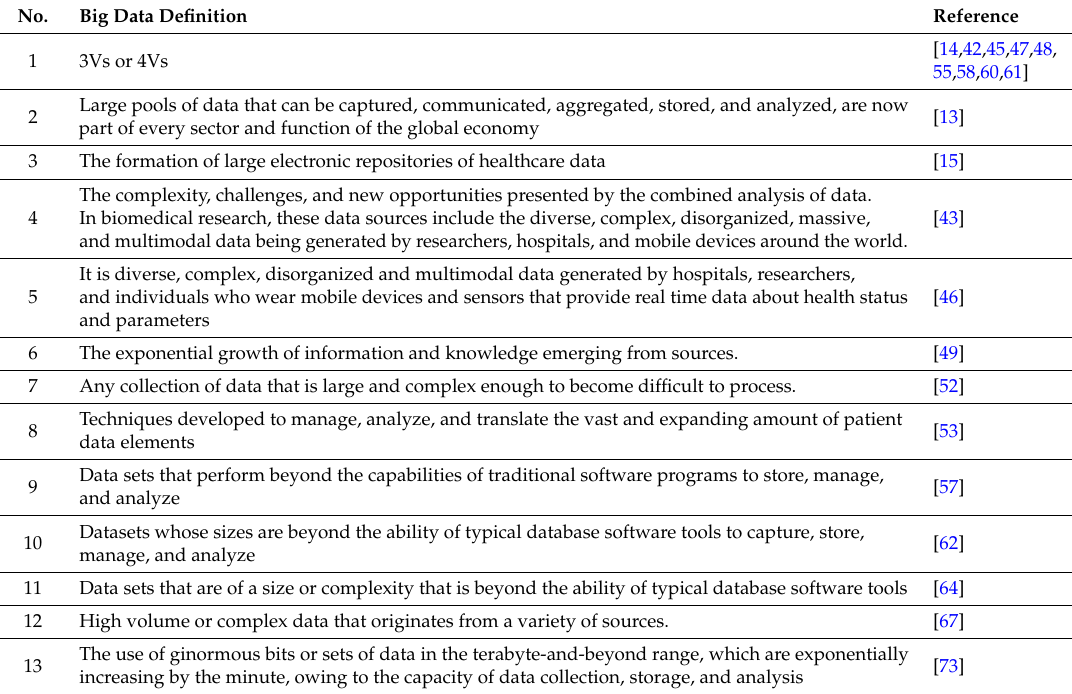
Table A2. The Big Data definition appeared in the 38 Big Data related publications PubMed Nursing